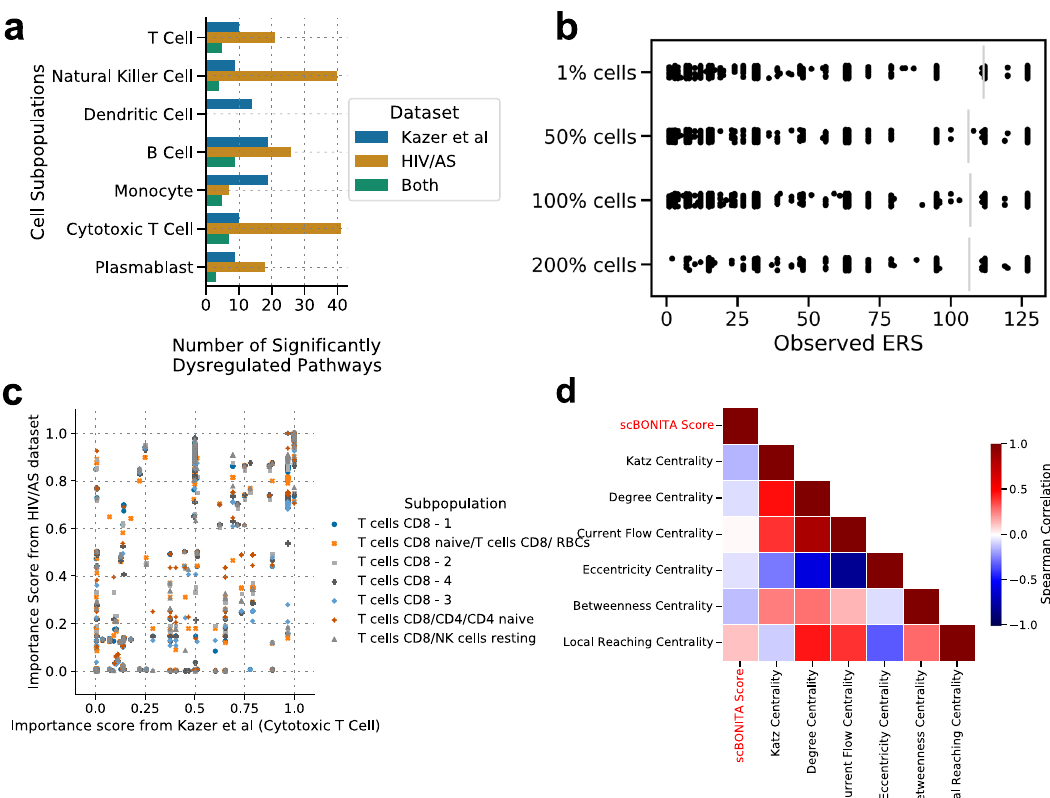
Fig. 7 Performance of scBONITA rule determination. a The number of pathways identi fi ed as signi fi cantly dysregulated (Bonferroni-adjusted p value < 0.05) one year upon HIV infection 38 , between AS + and AS − PLWH, and the intersections between these sets. Subpopulations from the two datasets were matched as shown in Supplementary Table 5. b Effects of the number of cells on the ERS size evaluated by downsampling and augmentation using the largest cluster ( “ B cells naïve – 1 ” ) from the HIV/AS dataset. c Relation between importance scores in 130 KEGG networks evaluated using CD8 + T cells from two comparisons — AS + and AS − PLWH and from persons before and one year after HIV infection 38 . d Spearman correlation coef fi cients ( p < 0.01 for all comparisons) between scBONITA ’ s node importance score (labeled as ‘ scBONITA score ’ ) and 6 measures of node centrality (along x and y-axis ). Correlation coef fi cients are depicted by colors ranging from blue ( − 1) to red ( +